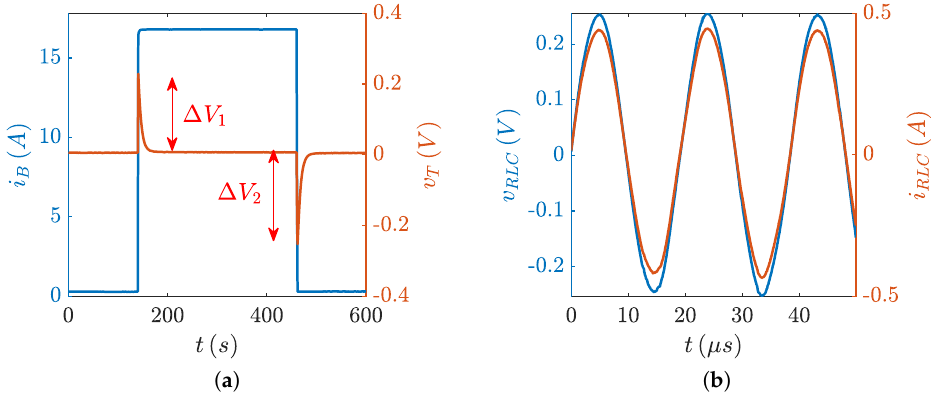
Figure 6. Terminal voltage v T and current i B of the battery during the pulsed current test used to extract the series-resistance, as acquired by the oscilloscope. The voltage probe was AC coupled to improve the accuracy of the voltage drop measurement ( a ). Voltage and current waveforms of the circuit used to measure the battery stray inductance when in resonance ( b